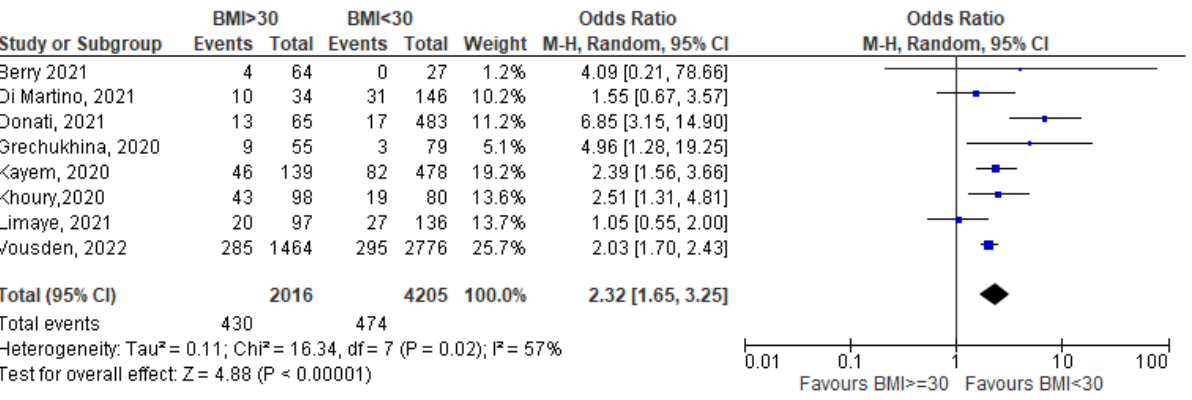
Figure 2. BMI > =30 vs. BMI < 30 — disease severity (critical/severe vs. mild) [15 – 22]. Maternal death due to COVID-19-related causes